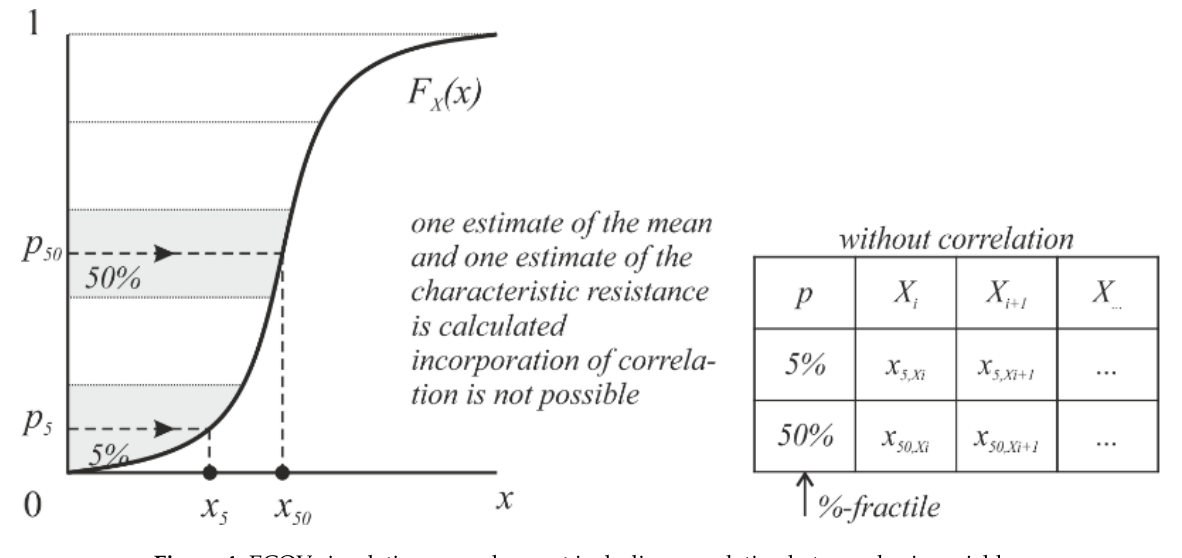
Figure 4. ECOV simulation procedure not including correlation between basic variables.